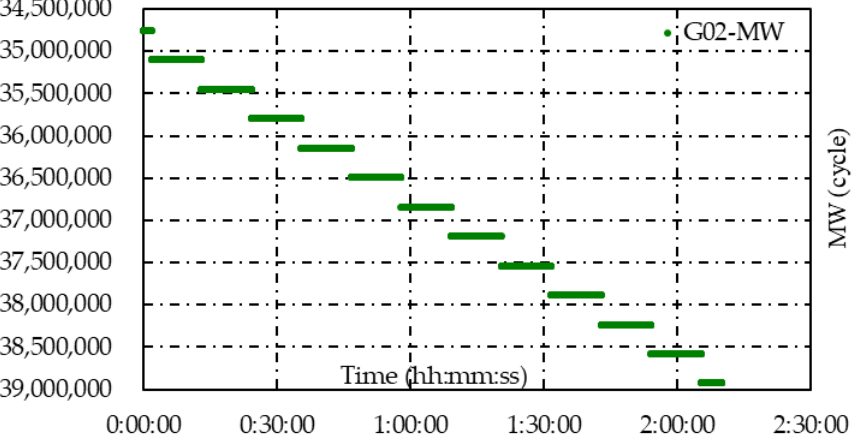
Figure 14. Receiver clock error of PIXI with GPS.